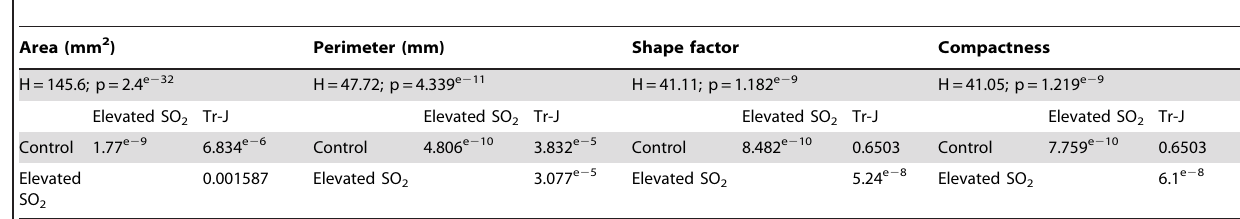
Table 2. Kruskal Wallis and Mann-Whitney pair-wise comparisons for each physiognomic trait in Lepidozamia hopei in the different simulated palaeoatmospheric